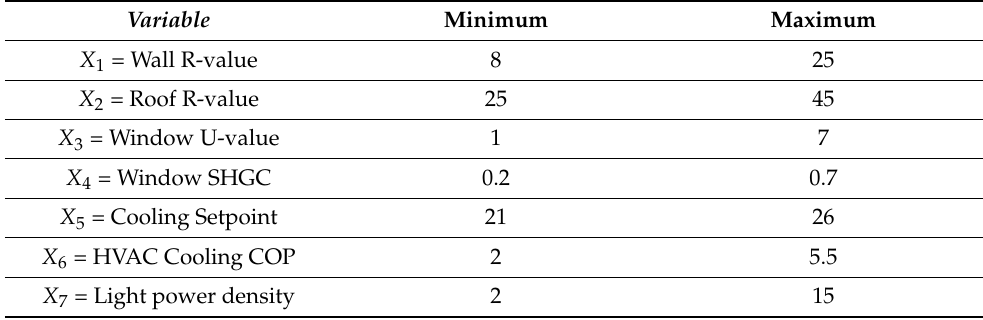
Table 3. Optimization variables and